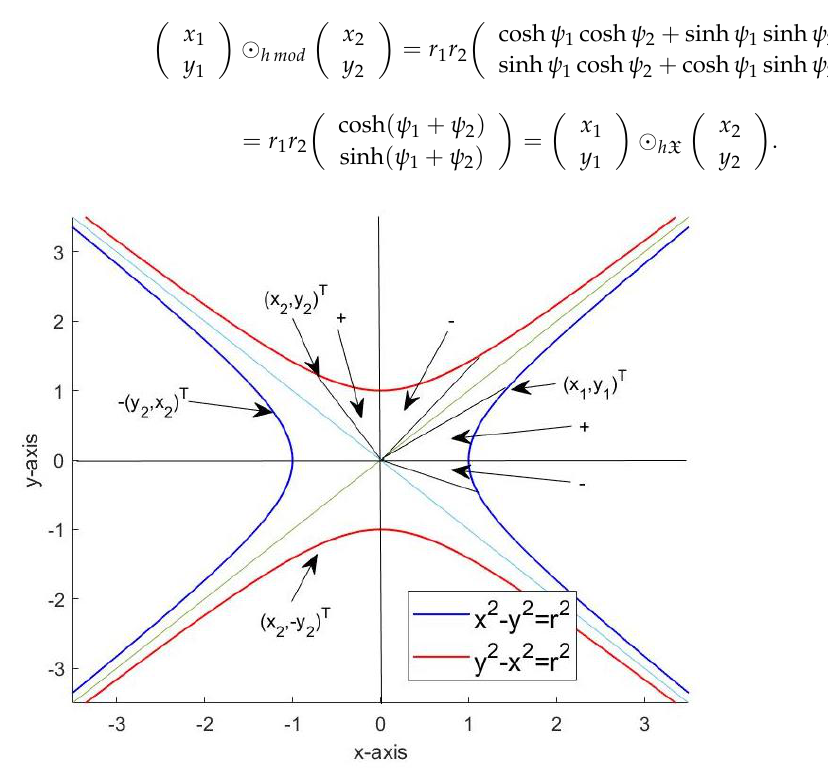
Figure 7. Signs of area